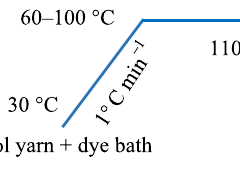
Figure 2. Dyeing of wool yarn with natural dye.